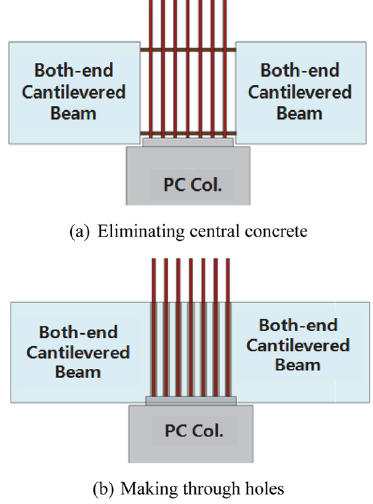
Fig. 3. Types of central parts in both-end cantilevered